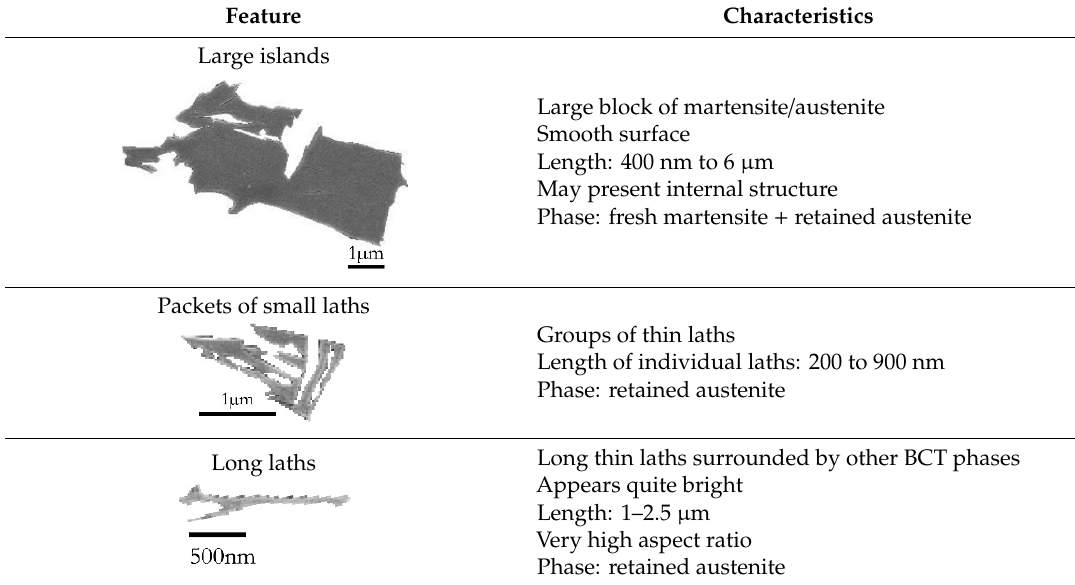
Table 2. The different features and characteristics of martensite/austenite islands in the Q&P microstructure.